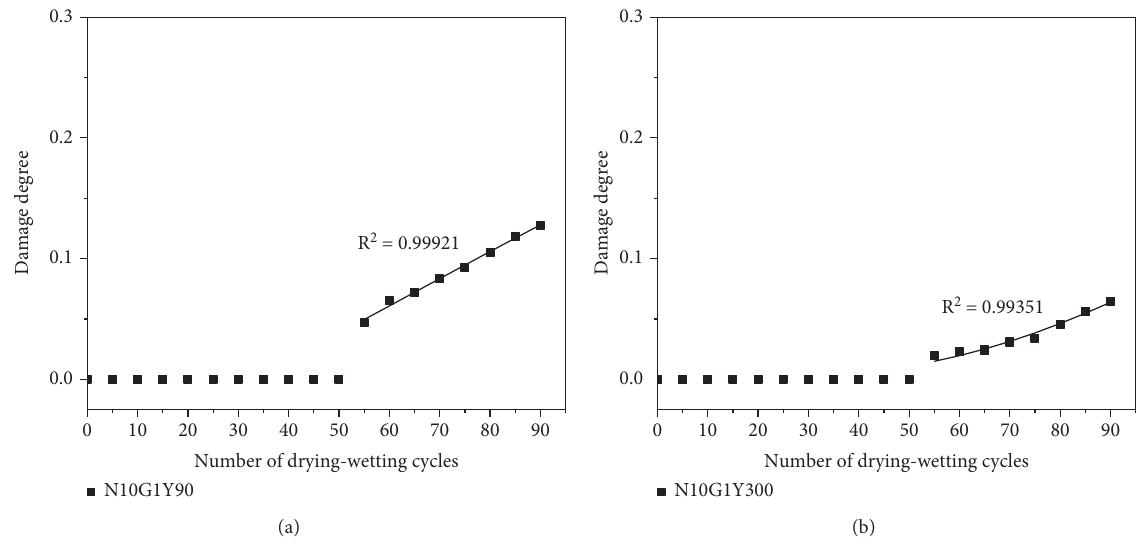
Figure 11: Variation of the concrete damage degree at increasing curing times. (a) N10G1Y90. (b) N10G1Y300.